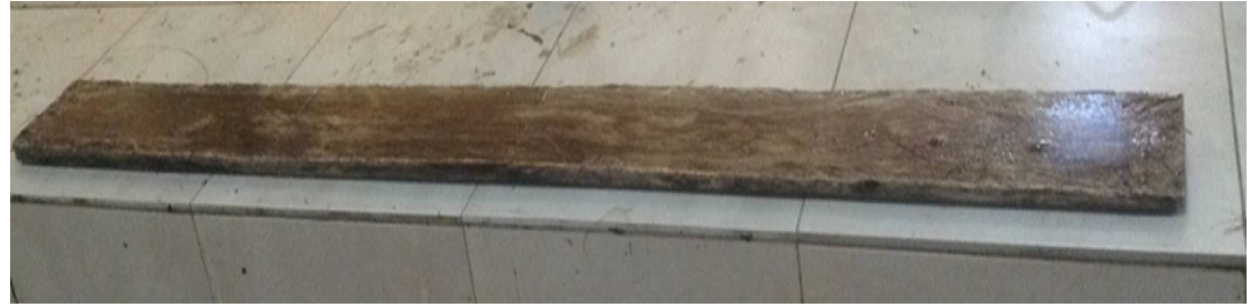
Figure 2. Fabricated bamboo laminate.